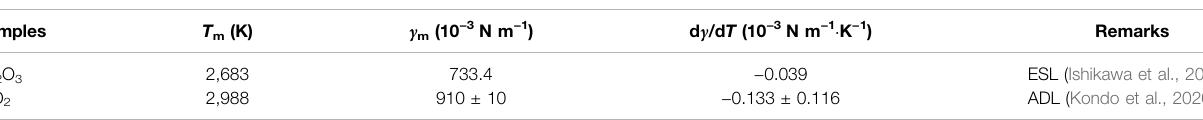
TABLE 5 | Surface tension of molten Ln 2 O 3 and ZrO 2 . Samples